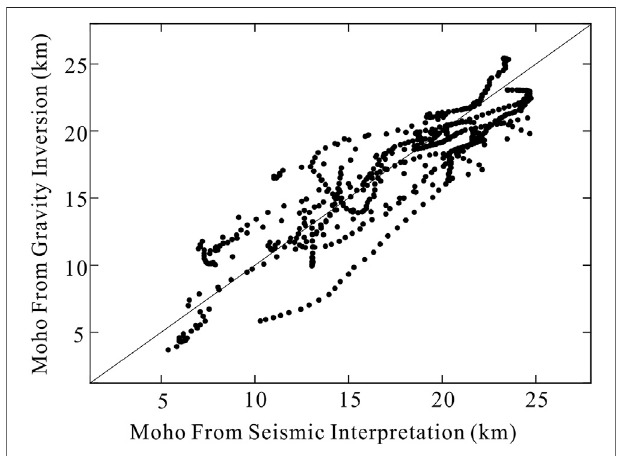
FIGURE 6 | Moho depth from gravity inversion vs. that from seismic interpretation. The root mean square (RMS) between them is 2.28 km.